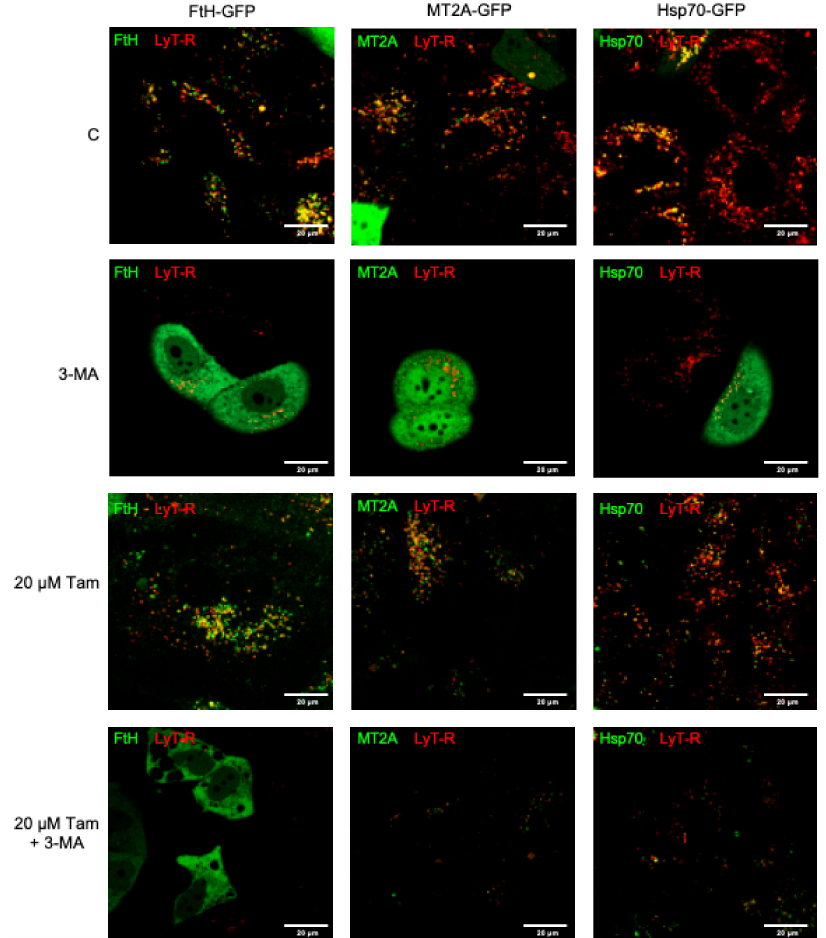
Figure 7. Inhibition of autophagy restores susceptibility to Tam-induced LMP in MCF7 cells over- expressing MT2A, FtH, or Hsp70. Cells transfected as indicated were left untreated (first row) or treated with 5 mM 3-methyladenine (3-MA, 60 min pretreatment before Tam addition; second row), 20 µ M Tam for 2 h in the absence or presence of 3-MA (third and fourth row, respectively). After staining with LysoTracker Red as in Figure 2a, cells were imaged by confocal